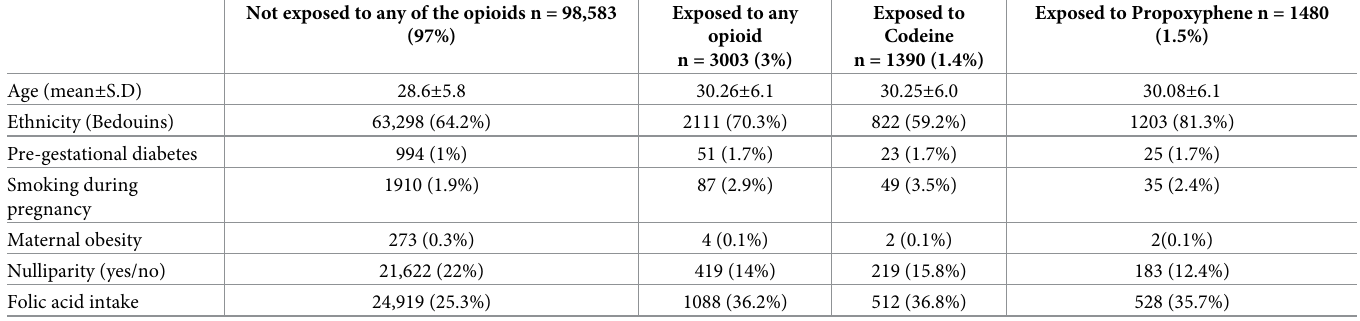
Table 1. Comparison of maternal characteristics of women unexposed to any of the opioids during the first trimester of pregnancy to women exposed to any of the opioids and to codeine or propoxyphene alone. Not exposed to any of the opioids n = 98,583 (97%)